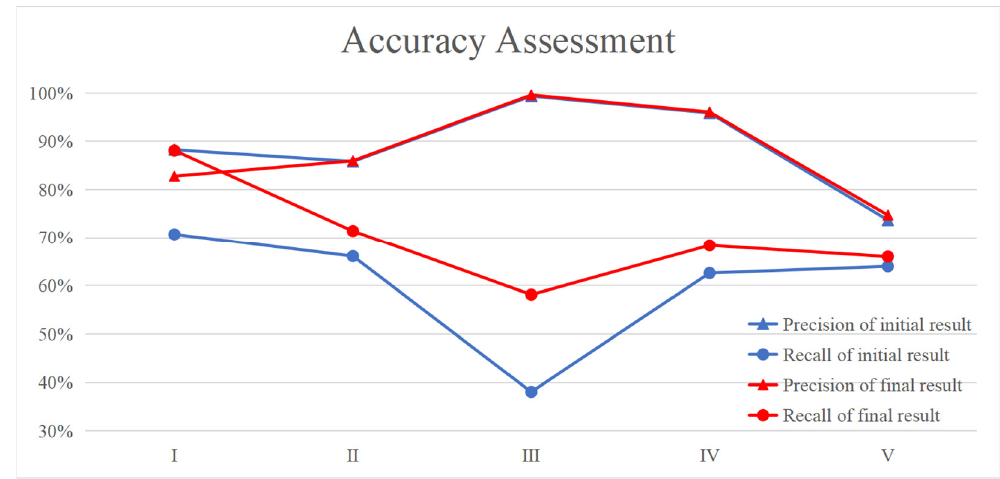
Figure 12. Accuracy assessment comparison for the initial and final results.